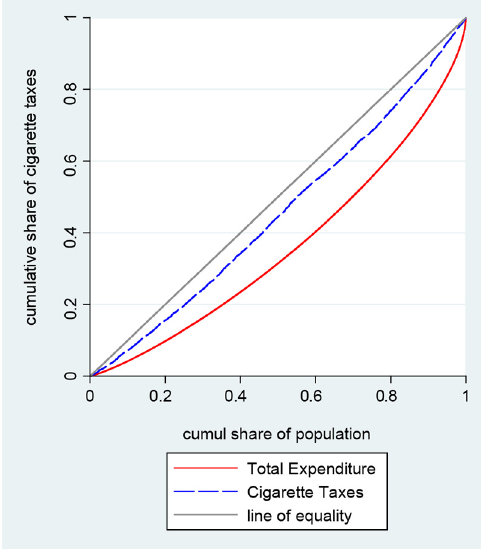
Figure 5. Concentration